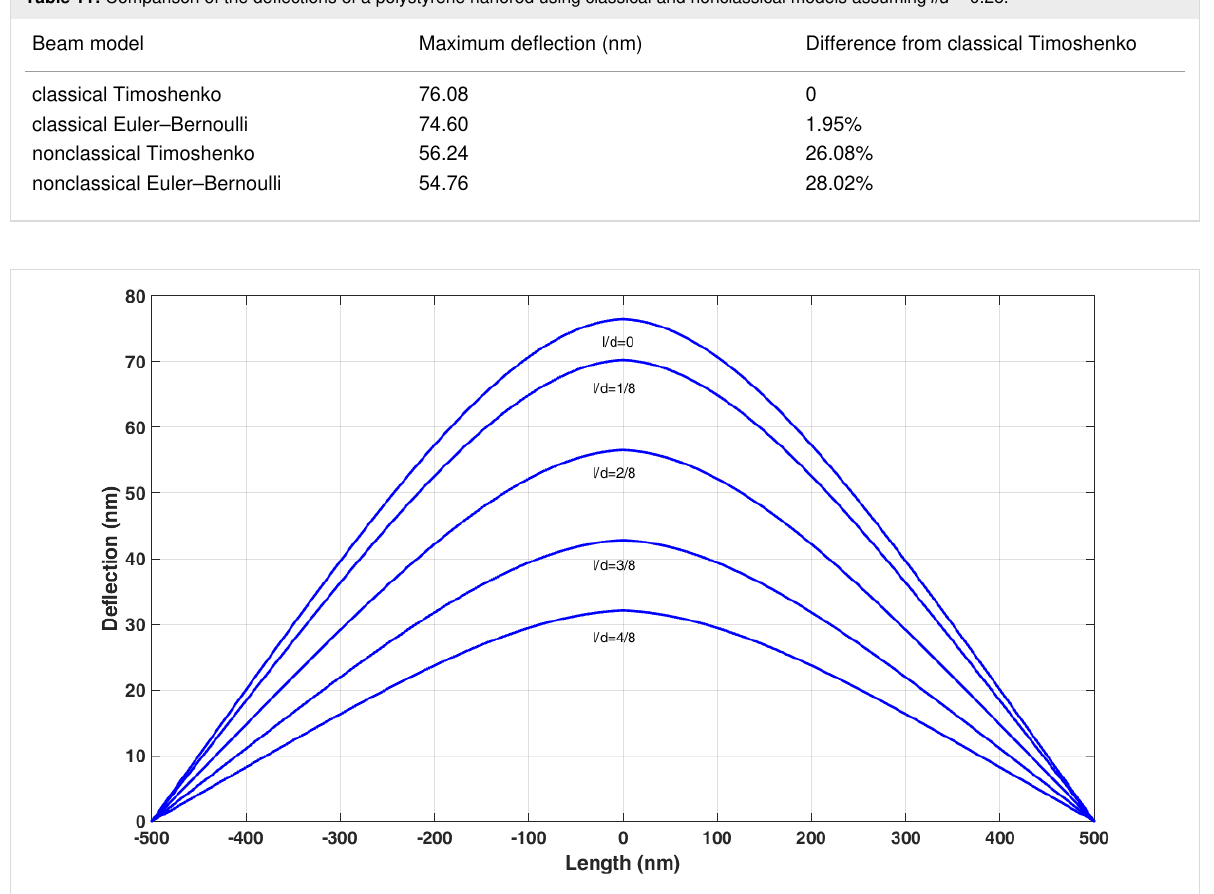
Figure 21: Comparison of polystyrene nanorod deflections in the nonclassical Timoshenko beam model with respect to l / d .